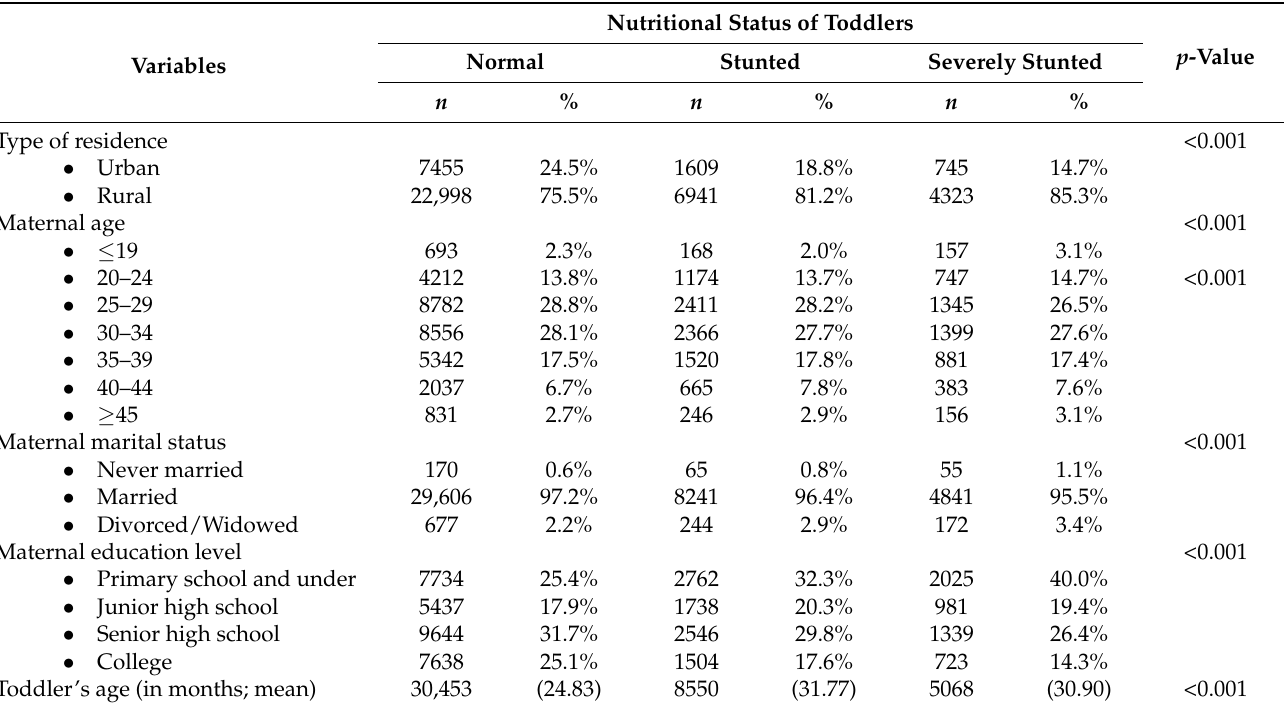
Table 1. Descriptive statistics for stunted toddlers with working mothers in Indonesia, 2017 ( n =